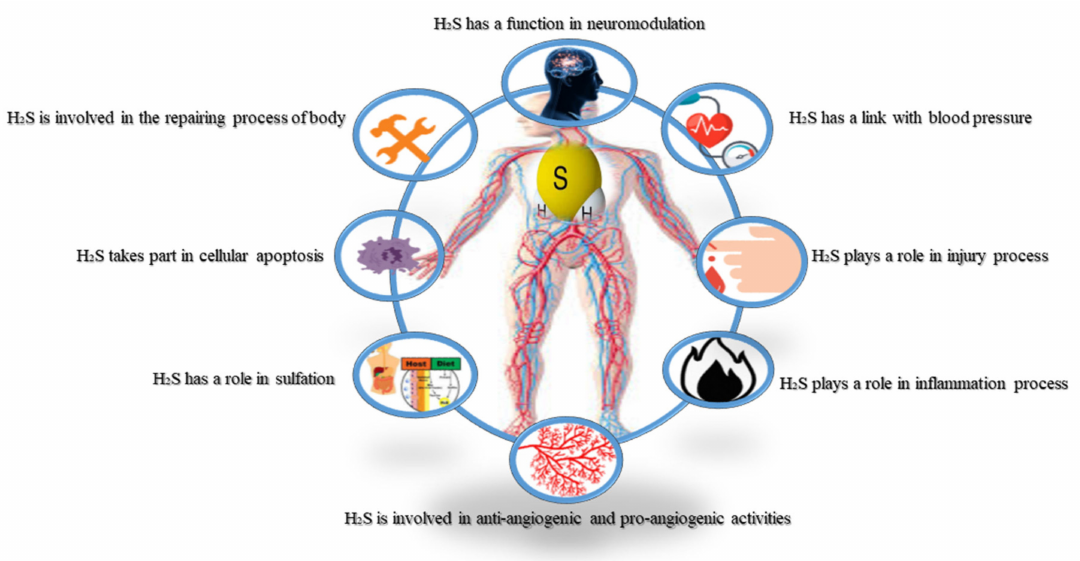
Figure 1. A schematic diagram showing the roles of H 2 S in human physiology and pathology. H 2 S is formed through- out the body and moderates signaling processes in various tissues, including neuromodulation, blood pressure, injury, inflammation, anti-angiogenesis, pro-angiogenesis and sulfhydration apoptosis repair processes of the human body (H 2 S: hydrogen